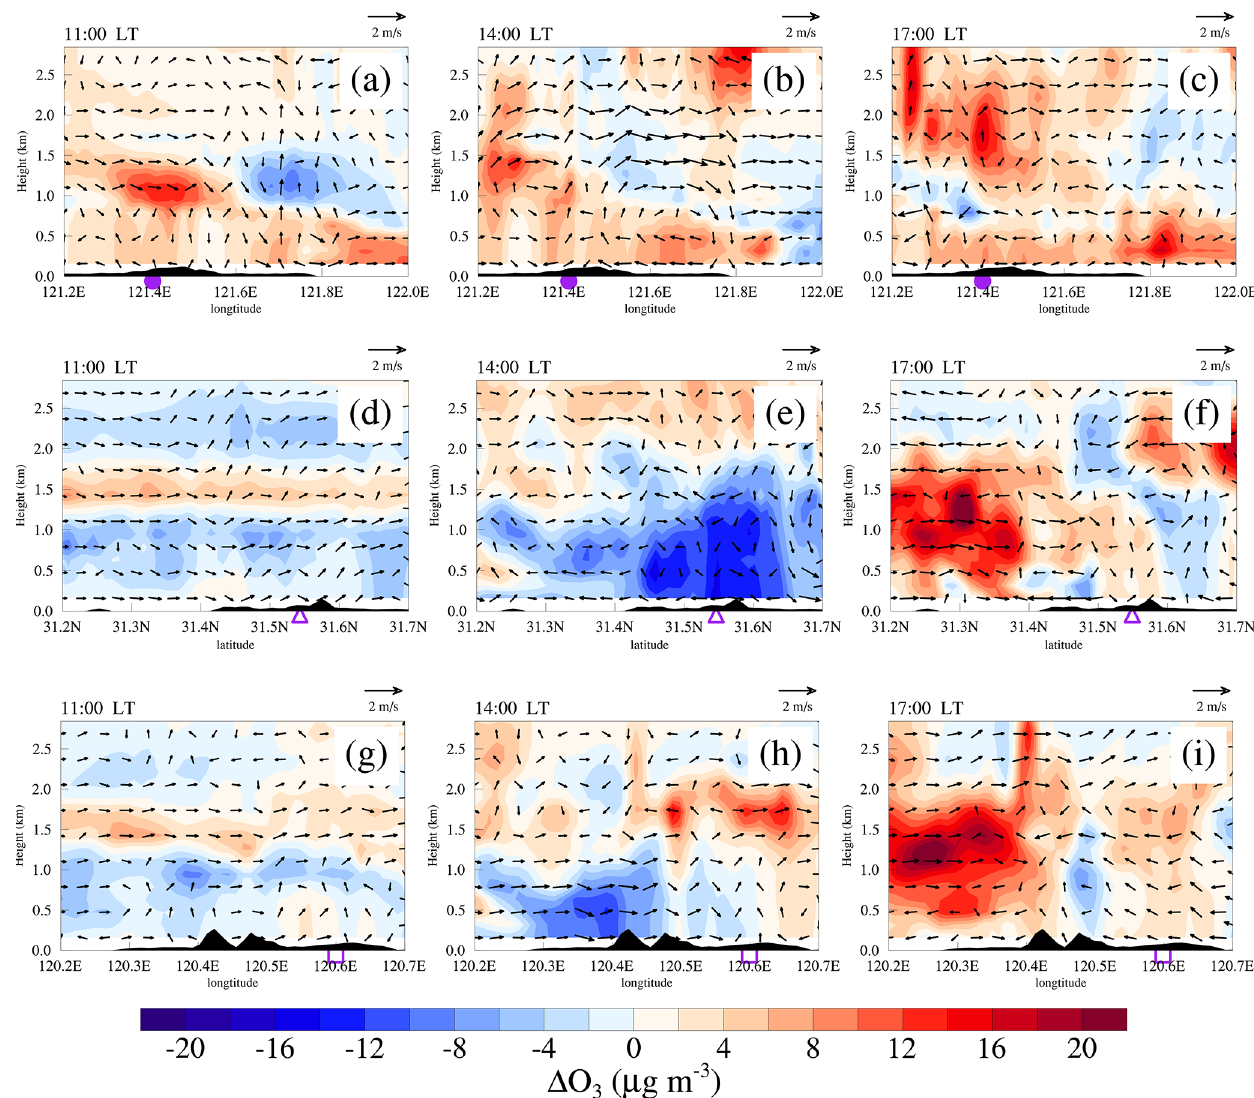
Figure 13. Same as Fig. 9 but for the differences between MODIS_AH and MODIS_noAH (MODIS_AH − MODIS_noAH).